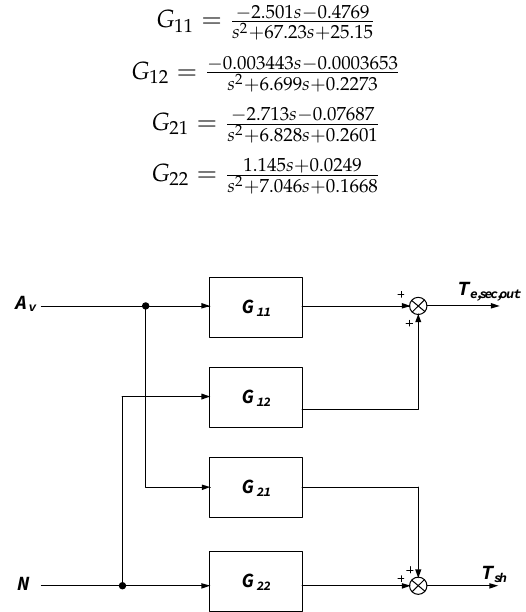
Figure 4. The structure of the linearized model.